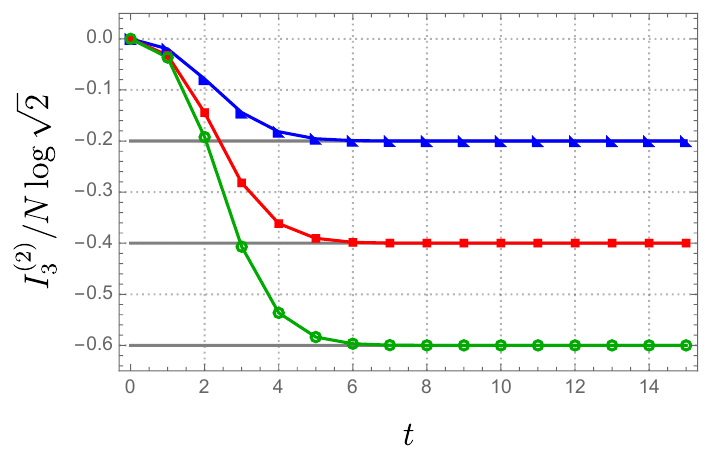
( 2 ) ( A ; C , D ) in the Majorana SYK model 3 ( 2 ) for the given value 3